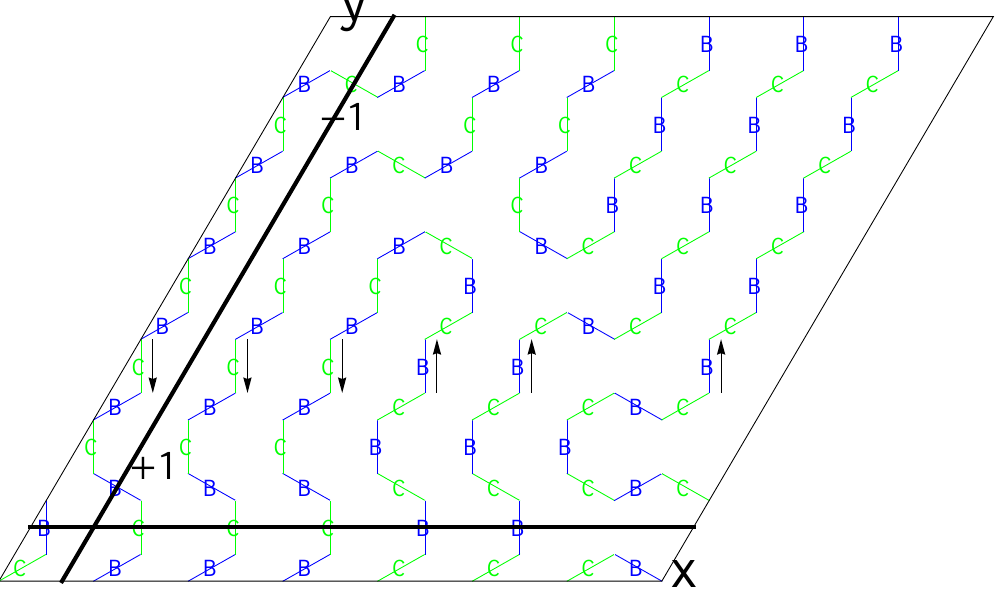
Figure 2: Same configuration as in Fig. 1 with red edges not shown, emphasizing closed self-avoiding B-C (blue-green) loops, which can be seen as flux lines through the x and y lines. Orientation of the loops is defined in Fig. 3. There are three types of flux lines (not shown) which